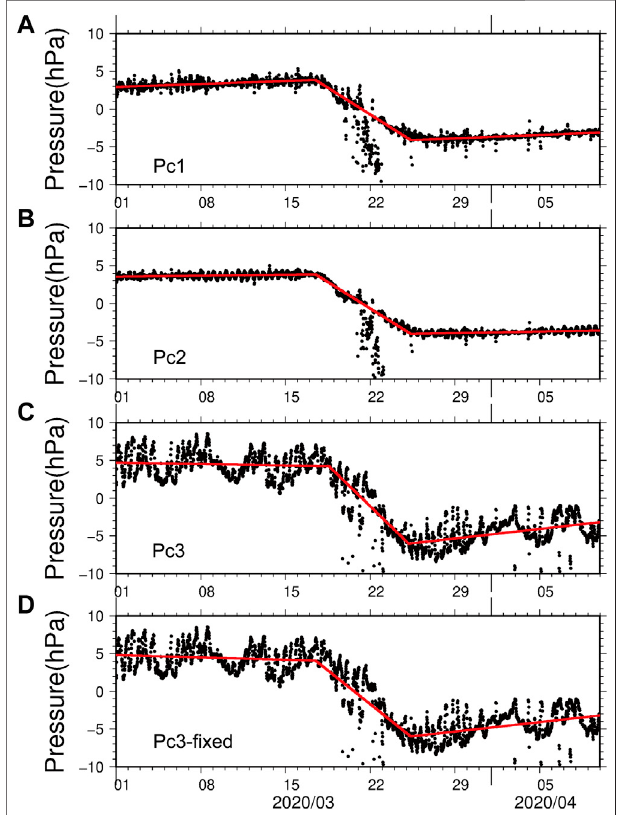
FIGURE 5 | Time history of the pore pressure (dotted black: 20 min sampling) with the fi tting regression lines (red) for (A) Pc1, (B) Pc2, (C) Pc3, and (D) Pc3 under the same time of onset and termination as Pc1 and